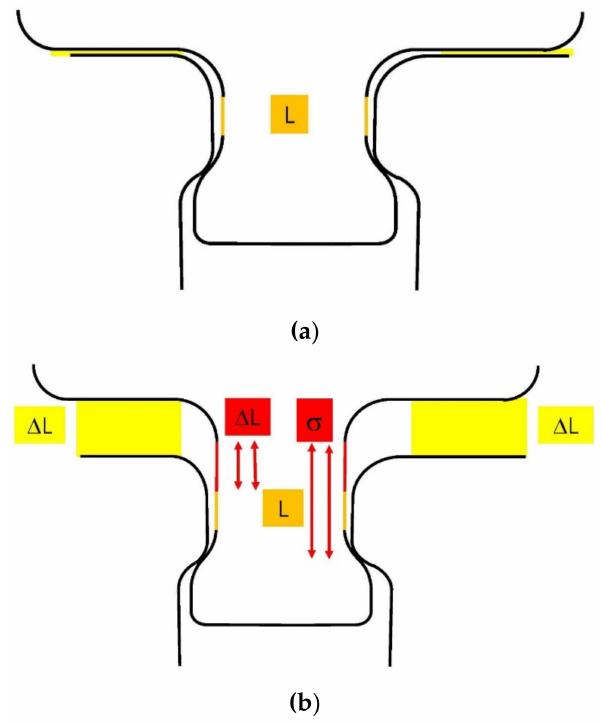
Figure 6. Wedging effect caused by corrosion products in the gap: ( a ) initial state (black = blade root and mounting block) and ( b ) deposition of corrosion products in the gap (yellow), elongation of the root, and development of tension stress in the root